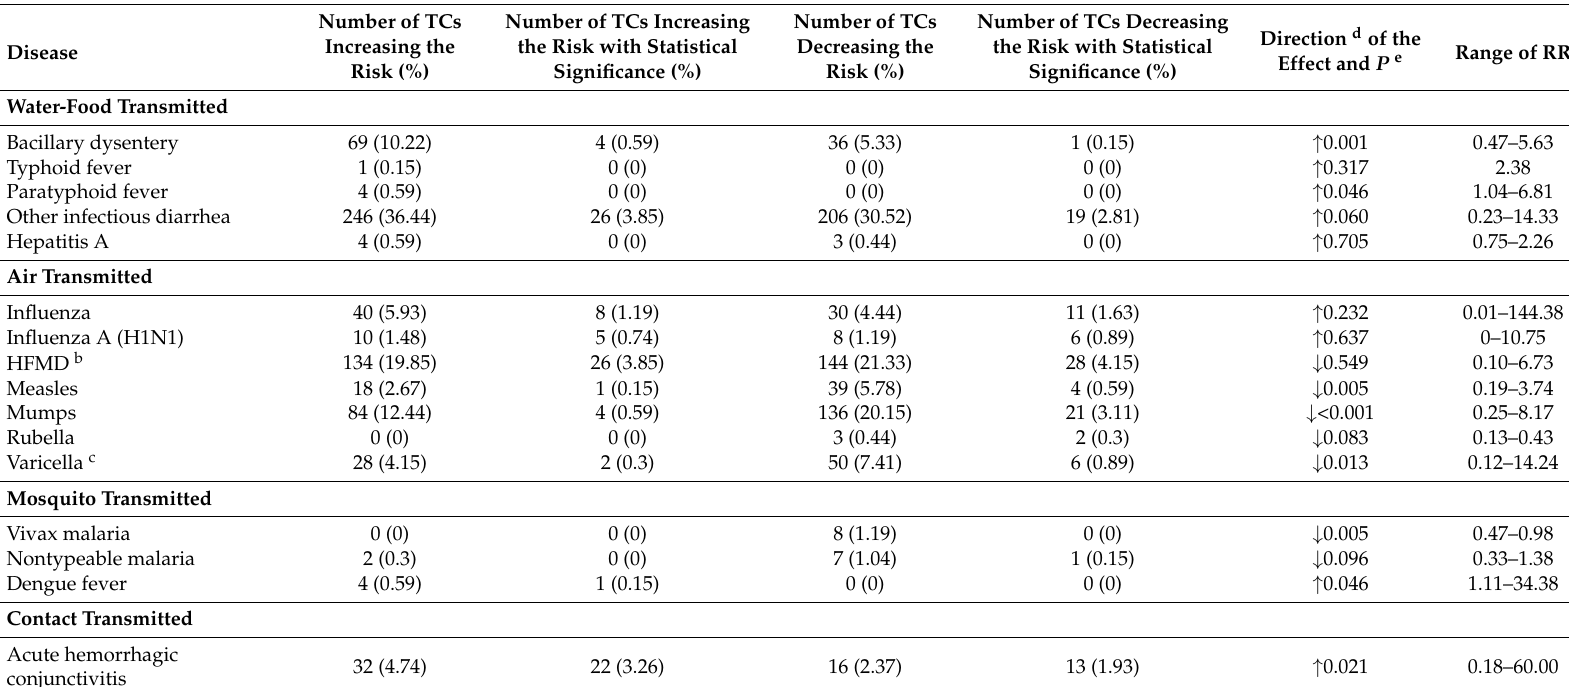
Table 4. Effects of TCs a on infectious diseases (Total TCs =